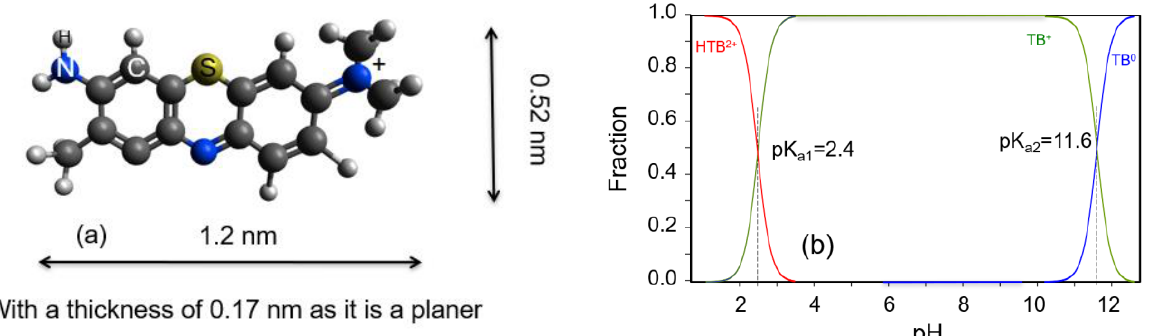
Figure 1. Molecular structure of TB ( a ) and its pH-speciation relation ( b ).